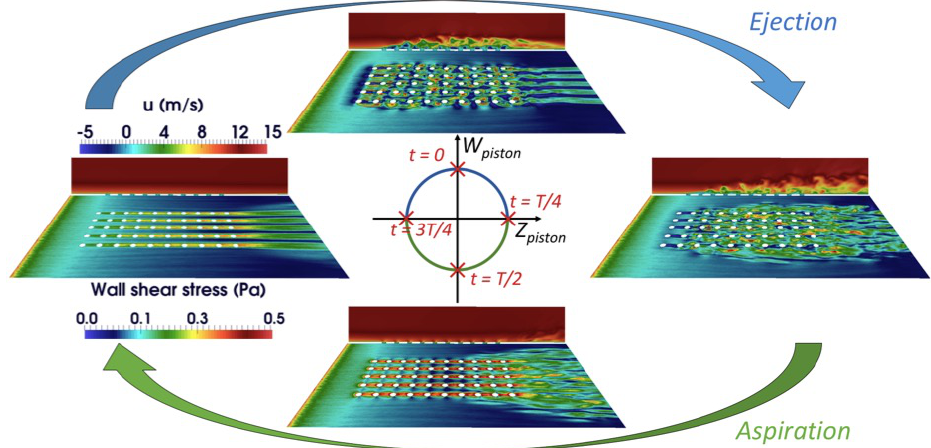
Figure 5. Flow evolution along a period T for the lab-scale configuration without turbulence in- jection: instantaneous axial velocity field in the symmetry plane and wall shear stress along the perforated